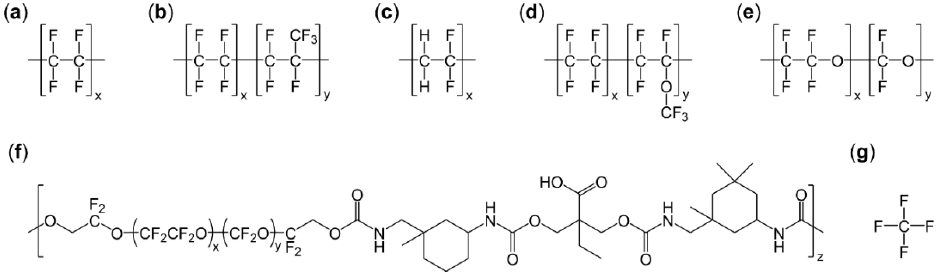
Figure 4. Fluorinated polymers most widely used for the hydrophobization of gas diffusion media in PEMFCs: ( a ) PTFE; ( b ) FEP; ( c ) PVDF; ( d ) PFA; ( e ) a generic PFPE; ( f ) Fluorolink ® P56 by Solvay, a commercial, high-molecular-weight, fluorinated polyurethane based on perfluoropolyether blocks; ( g ) CF 4 .